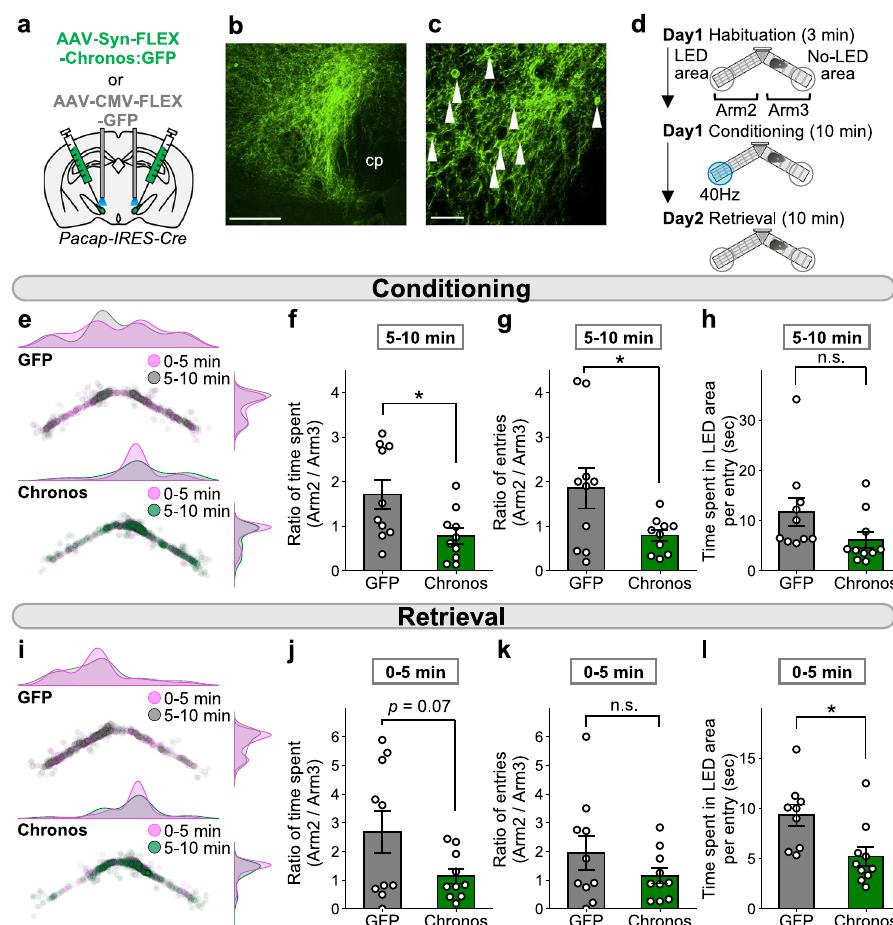
Fig. 7 | Photoactivation of the PACAP PSTN neurons promotes avoidance beha- viors and aversive learning. a Schematic illustration of bilateral injection into Pacap-IRES-Cre mice. b , c Representativeimagesof fl uorescentattheinjectionsite. Arrowheads indicate the cell bodies of Chronos:GFP-expressing cells. Scale bars represent 200 μ m ( b ) or 50 μ m ( c ). cp, cerebral peduncle. More than three inde- pendent experiments were conducted and similar results were obtained. d Experimental schedule of the place avoidance test. e Density and scatter plots showing the position of a representative mouse during the conditioning session (top, GFP; bottom, Chronos). f – h Summary of ratios of time spent in each arm,